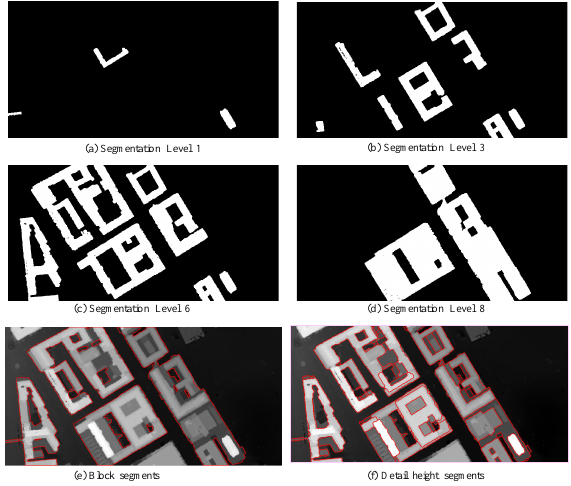
Figure 8: Hierarchical segmentation of different height levels of building